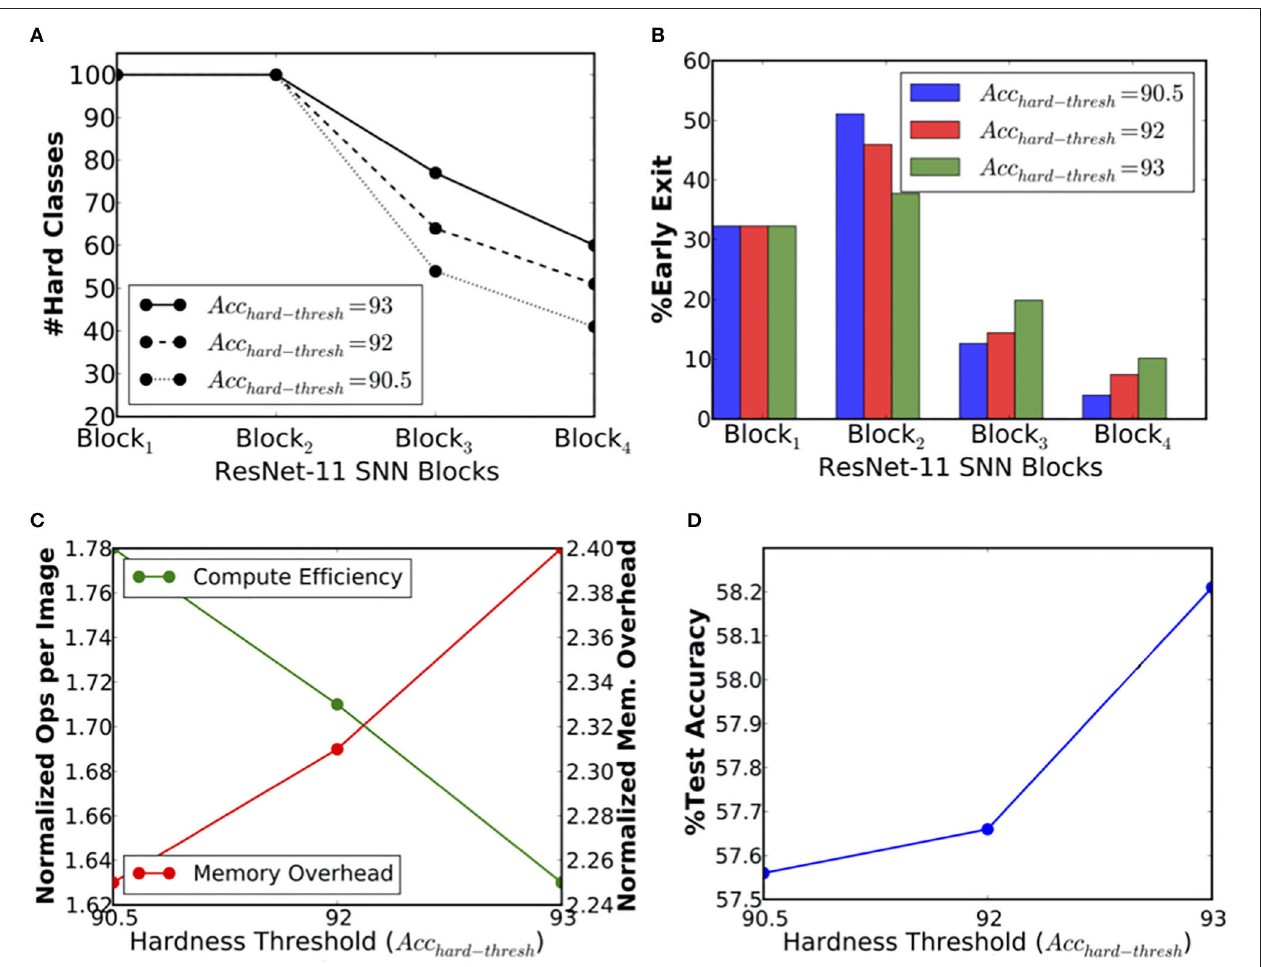
FIGURE 7 | (A) Number of output classes per block, (B) percentage of exiting inputs per block, (C) compute efficiency in terms of the normalized number of synaptic operations and memory overhead per inference, and (D) test accuracy vs. hardness threshold ( Acc hard − thresh ) for ResNet-11 spiking neural network (SNN) trained on the CIFAR-100